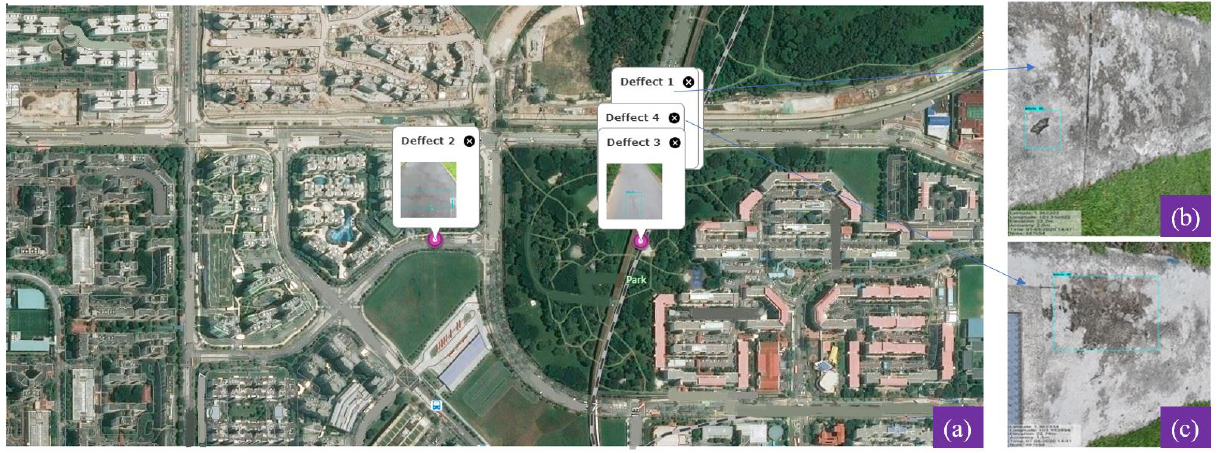
Figure 8. Independent trial for the mobile mapping system and the defect identification. ( a ) Defect location on global map, ( b , c ) detected defects and